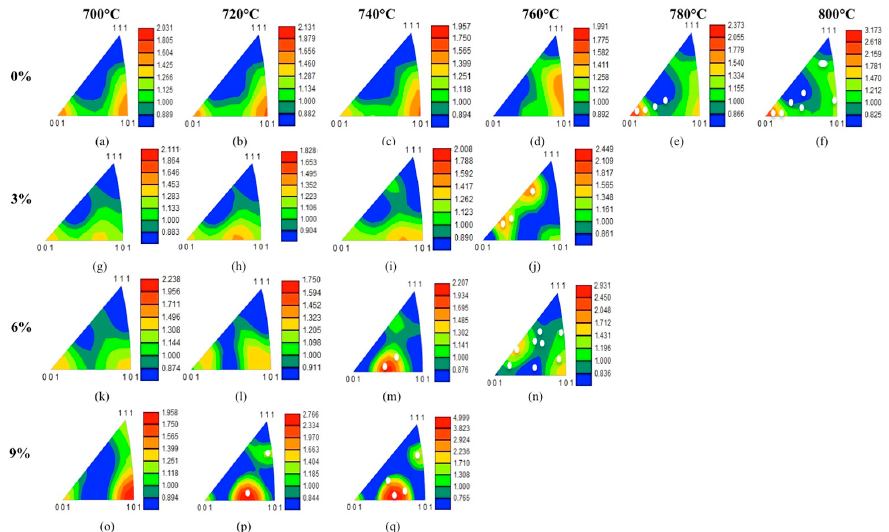
Figure 5. Inverse pole figure maps for 0% ( a – f ), 3% ( g – j ), 6% ( k – n ), and 9% ( o – q ) induced strain following annealing treatments ranging from 700 °C to 800 °C. White circles indicate the location of abnormally large grains. Orientation is shown with respect to the rolling direction (RD).